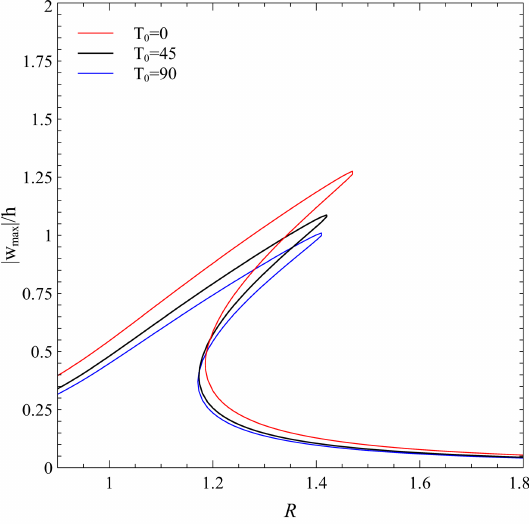
Figure 8. VS laminate [< T 0 |45>, 90< T 0 |45>] s : effect of angle T 0